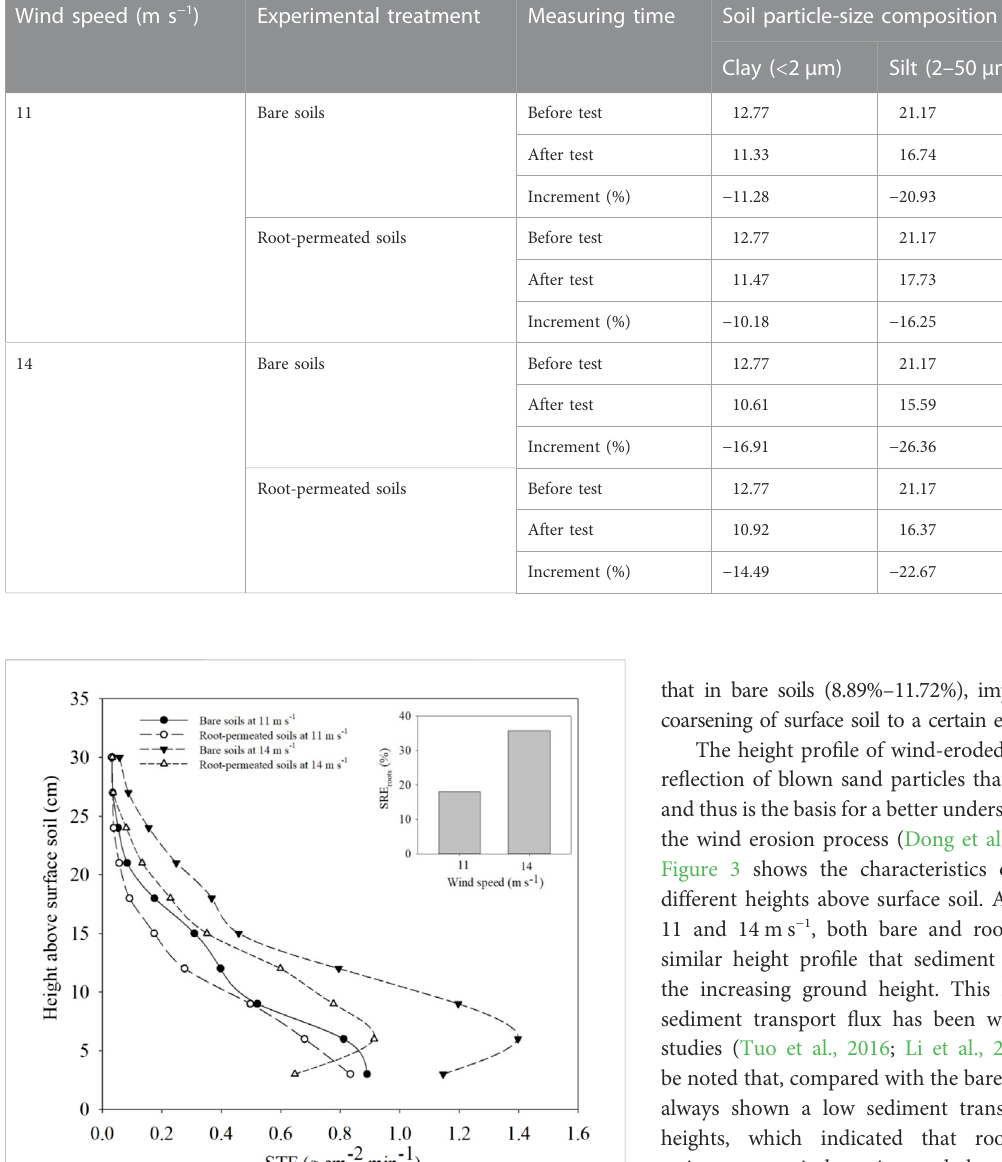
TABLE 3 Particle-size composition of experimental soils (0 – 1 cm) before and after wind tunnel tests. Wind speed (m s − 1 )